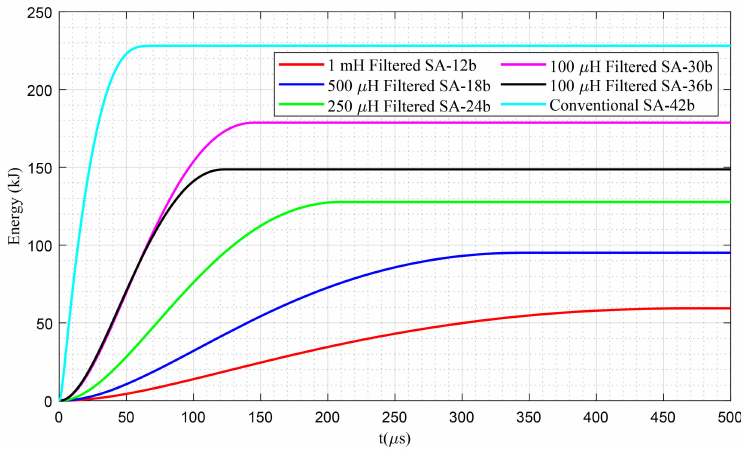
Figure 28. Comparison of the energy absorbed by di ff erent surge arresters against the 200 kV lightning impulse.